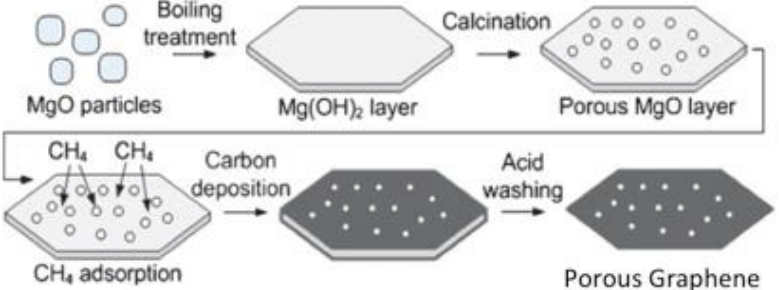
Figure 10. Schematic illustration of the preparation of porous graphene (modified from Ref. [82] with permission from Royal Society of Chemistry).